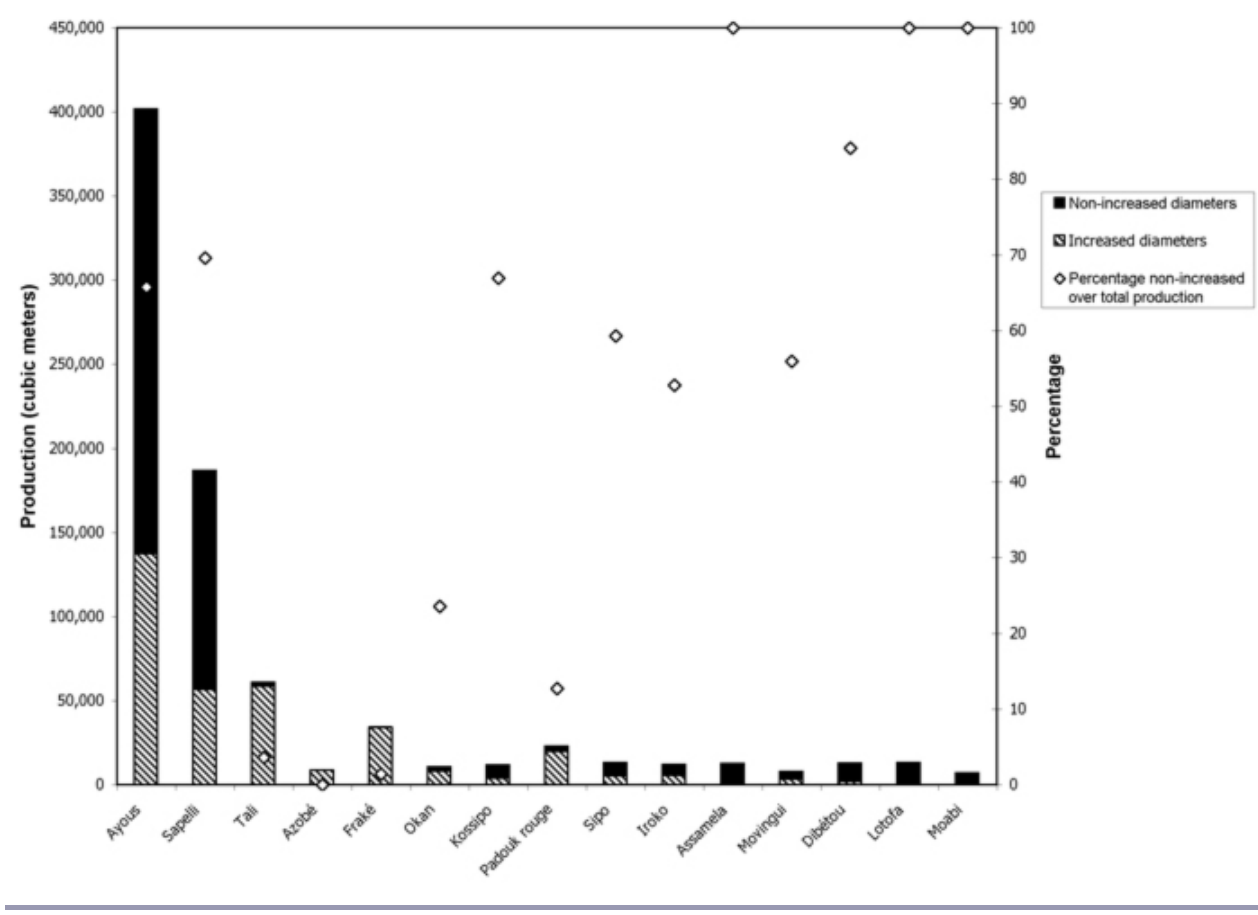
Fig. 3. Managed production of each species with no increase in MCD in concessions with approved management plans, 2006 (15 most-harvested